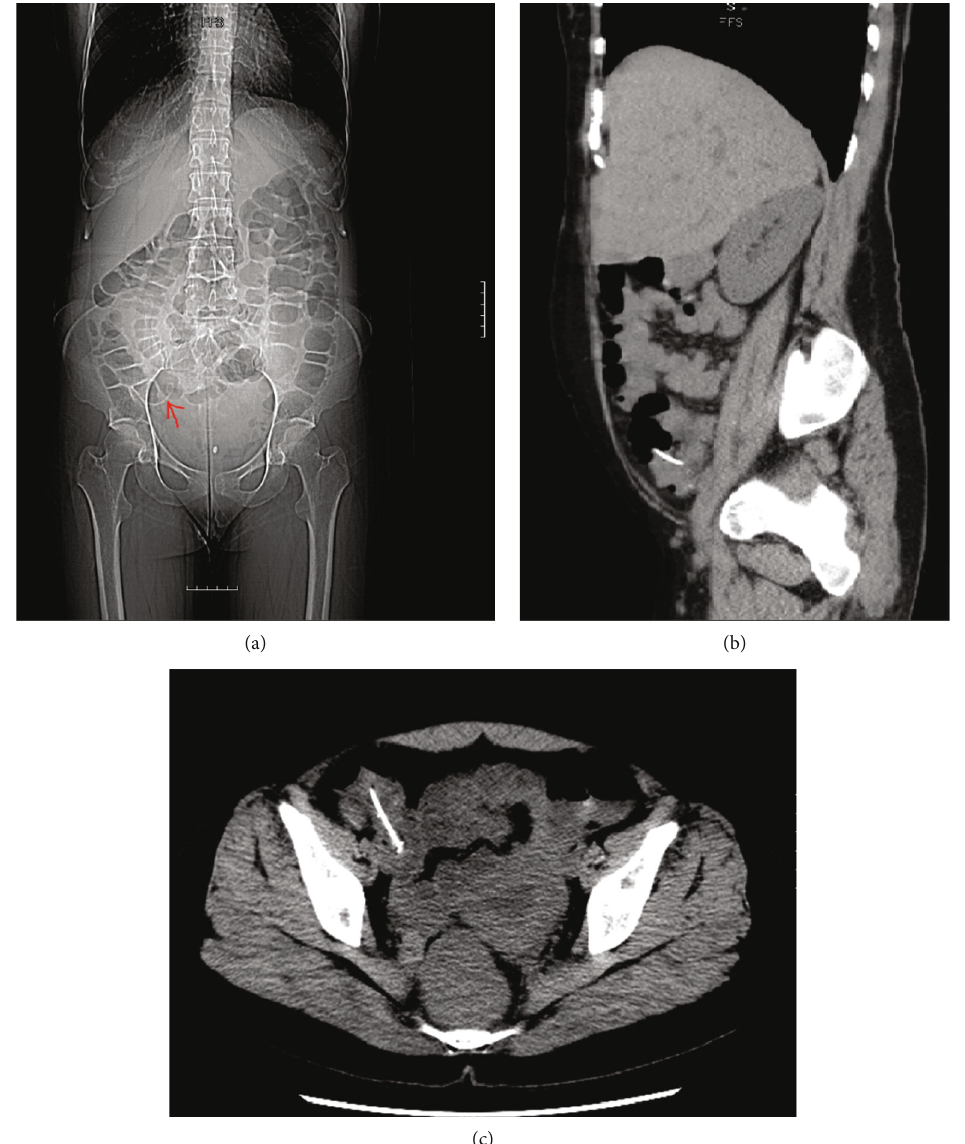
Figure 2: The CT scan showing a portion of the pigtail catheter lodged within the cecum in a coronal view (a), sagittal view (b), and axial view